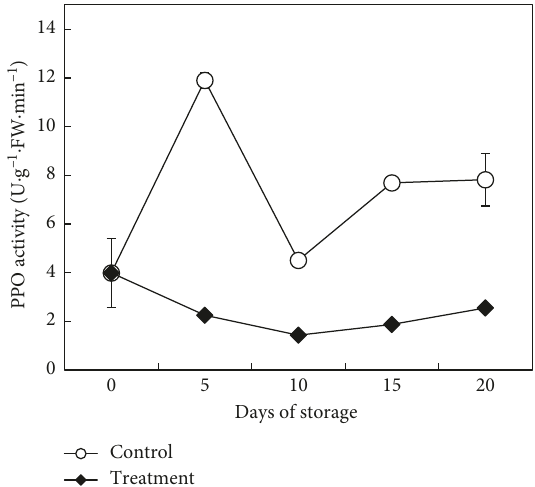
Figure 10: Effects of forced air precooling treatment on PPO